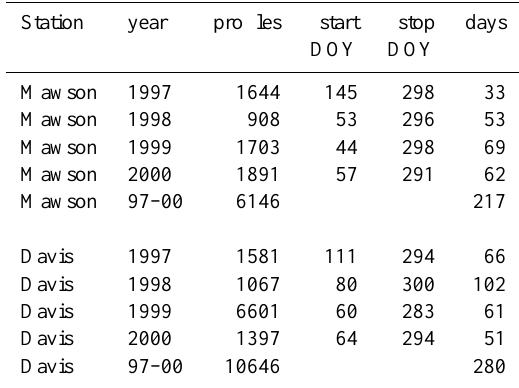
Table 1. λ 630nm observations from Mawson and